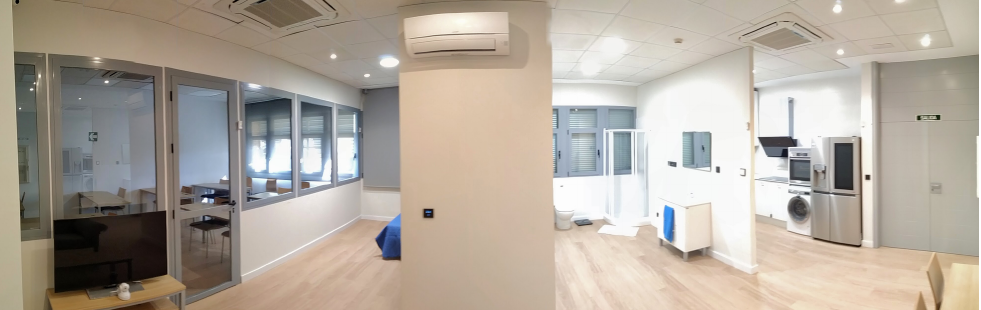
Figure 1. Smart Home of University of Almería